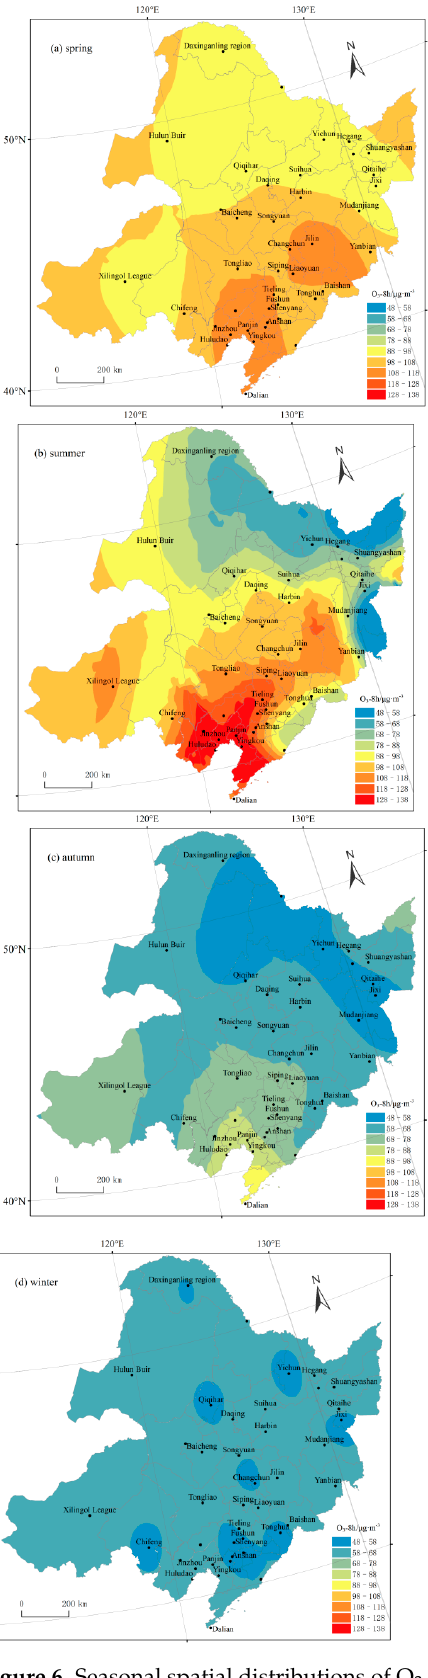
Figure 6. Seasonal spatial distributions of O 3 concentrations from 2017 to 2020 in Northeast China.